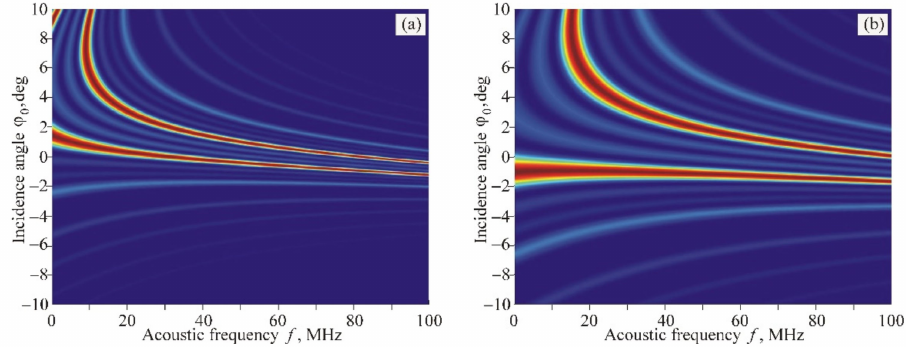
Figure 7. AO interaction areas for branch +1o in the case of m = 4 and different width of individual sections: ( a ) l = 0.15 mm; ( b ) l = 0.07